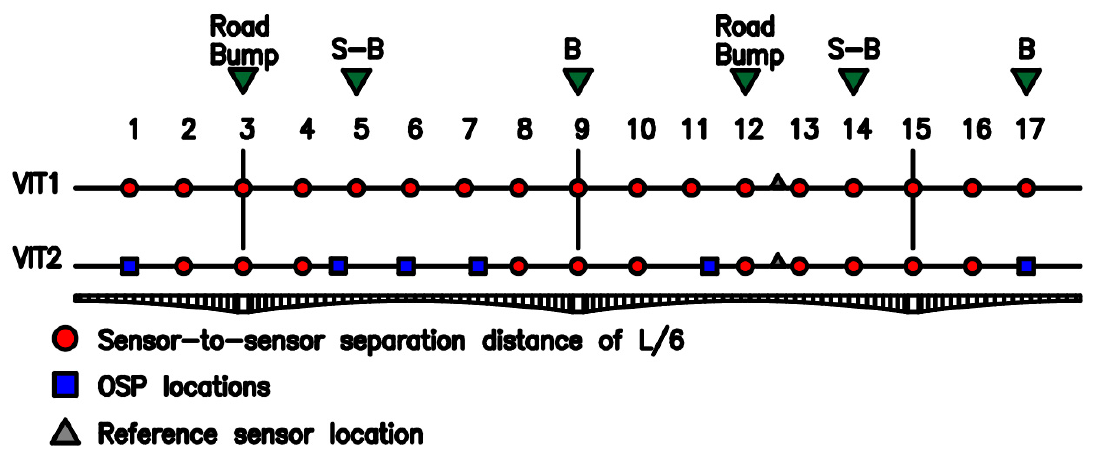
Figure 13. Location of sensors in VITs and braking B (moving forward) and S-B (moving in reverse).